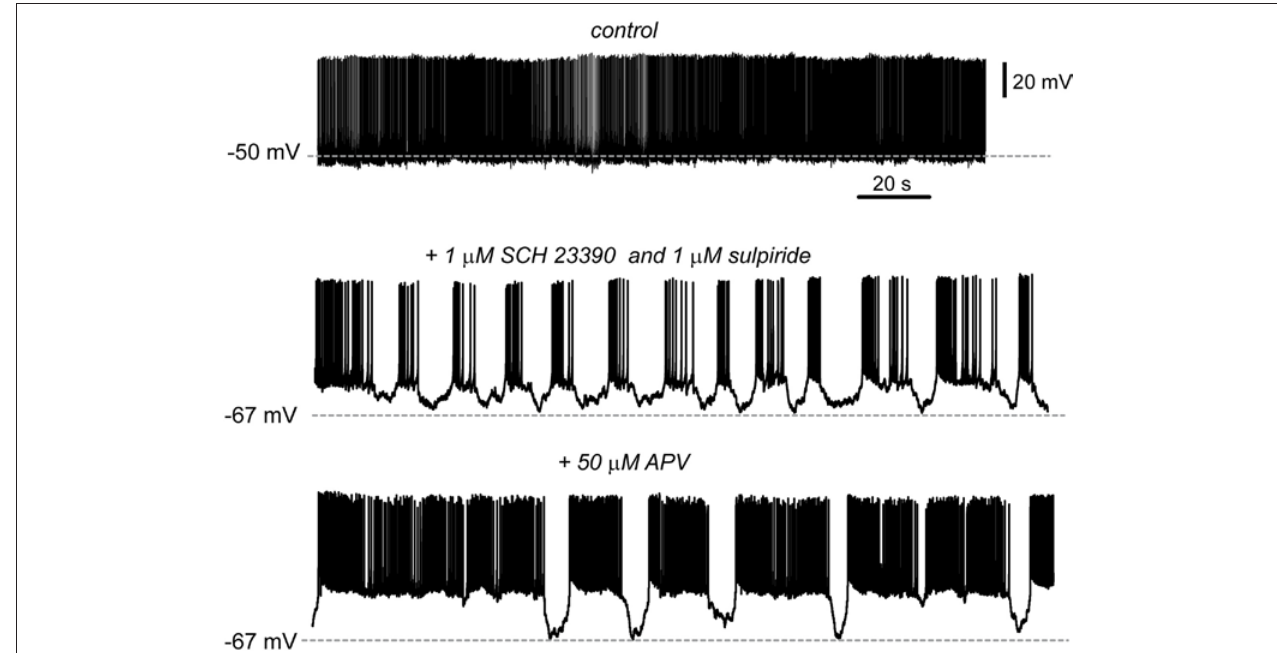
Figure 5 | Blockade of dopamine receptors changes the firing pattern of SNr neurons. Spontaneous tonic firing was the usual firing pattern recorded in SNr neurons in control conditions (top). During acute blockade of dopamine D and